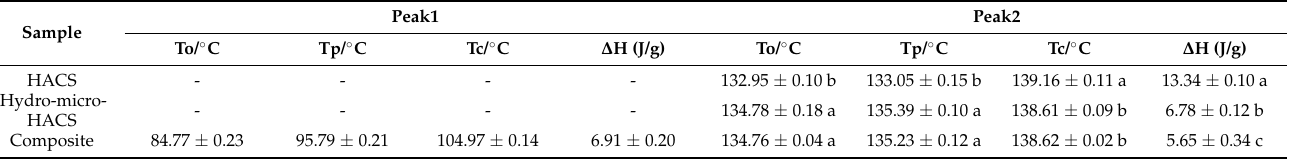
Table 2. DSC data of the HACS, hydro-micro-HACS, and